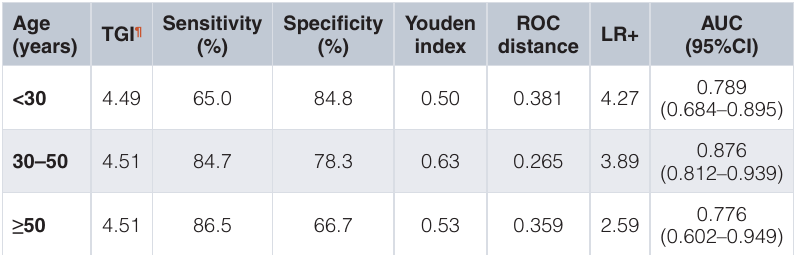
Table 5. Cutoff points for triglyceride-glucose index (TGI) selected in the reference population according to age groups, in Maracaibo city, Venezuela.